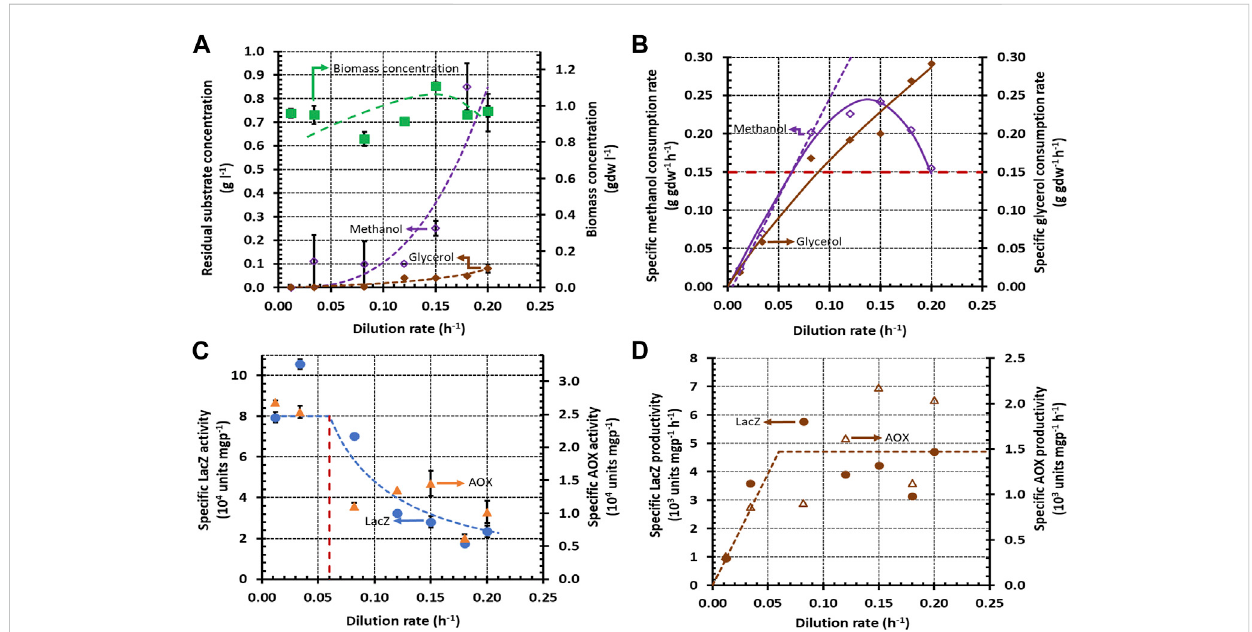
FIGURE 2 Variation of steady state concentrations with the dilution rate during growth of K. phaf fi i strain Mut + (pSAOH5-T1) in a chemostat fed with a mixture of glycerol (~1.5 g L − 1 ) and methanol (~1.6 g L − 1 ). (A) Concentrations of biomass, residual glycerol, and residual methanol (B) Speci fi c methanol and glycerolconsumptionratescalculatedfromthedatain (A) usingEq.5.Thedashedlinepassingthroughtheoriginshowsthelinearincreaseofthespeci fi c methanol consumption rate in the dual-limited regime. The horizontal dashed line shows the threshold speci fi c methanol consumption rate